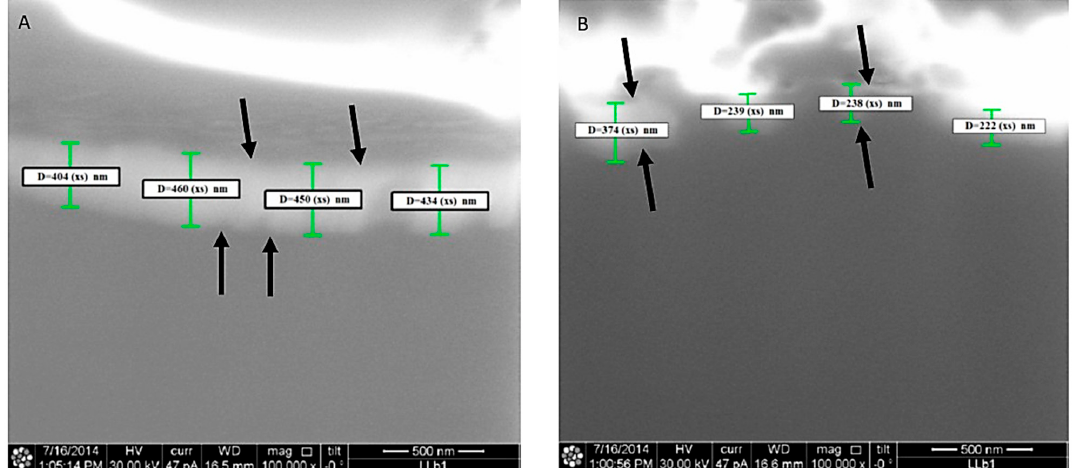
Figure 4. Thickness oxidation layer of a lasered implant (Arrows). ( A ) Inside a hole. ( B ) Outside a hole.